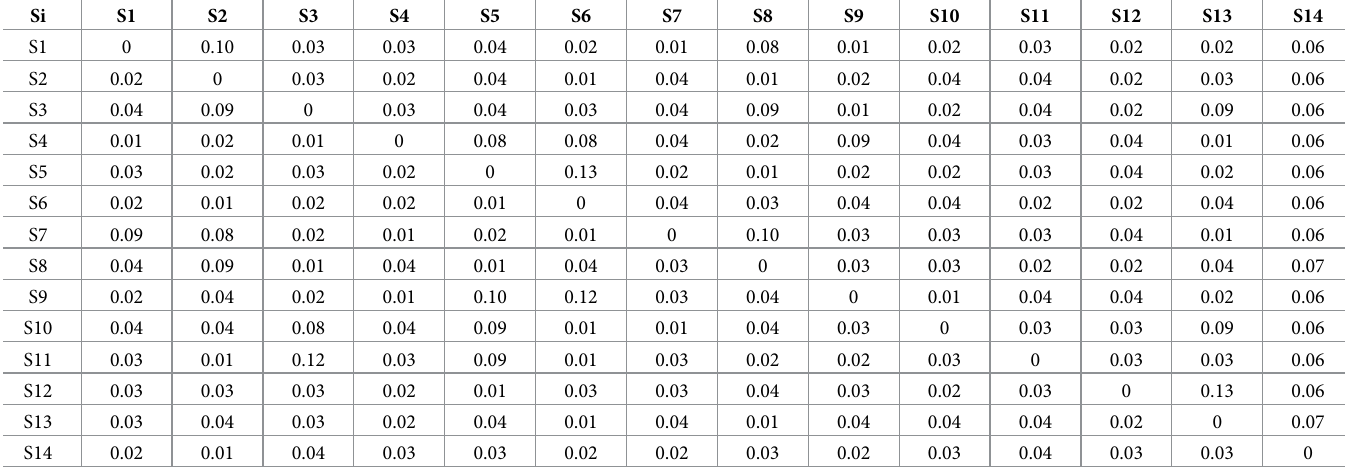
Table 4. The fuzzy relation strength matrix B n